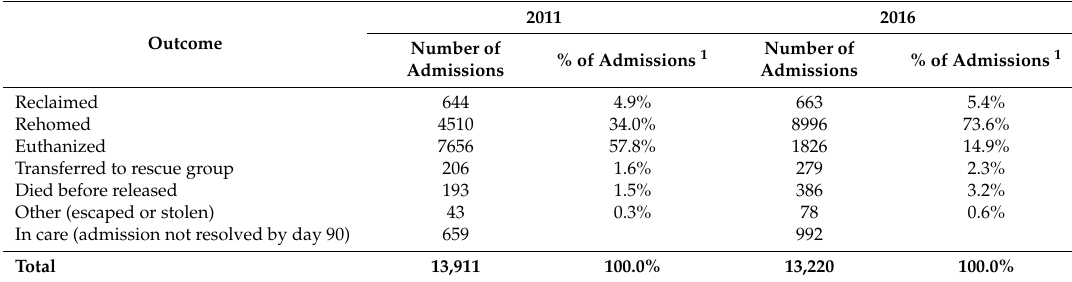
Table 4. Distribution of outcomes of cat admissions for all admissions to RSPCA Queensland shelters in 2011 and 2016 and the percentage of each resolved by day 90 of